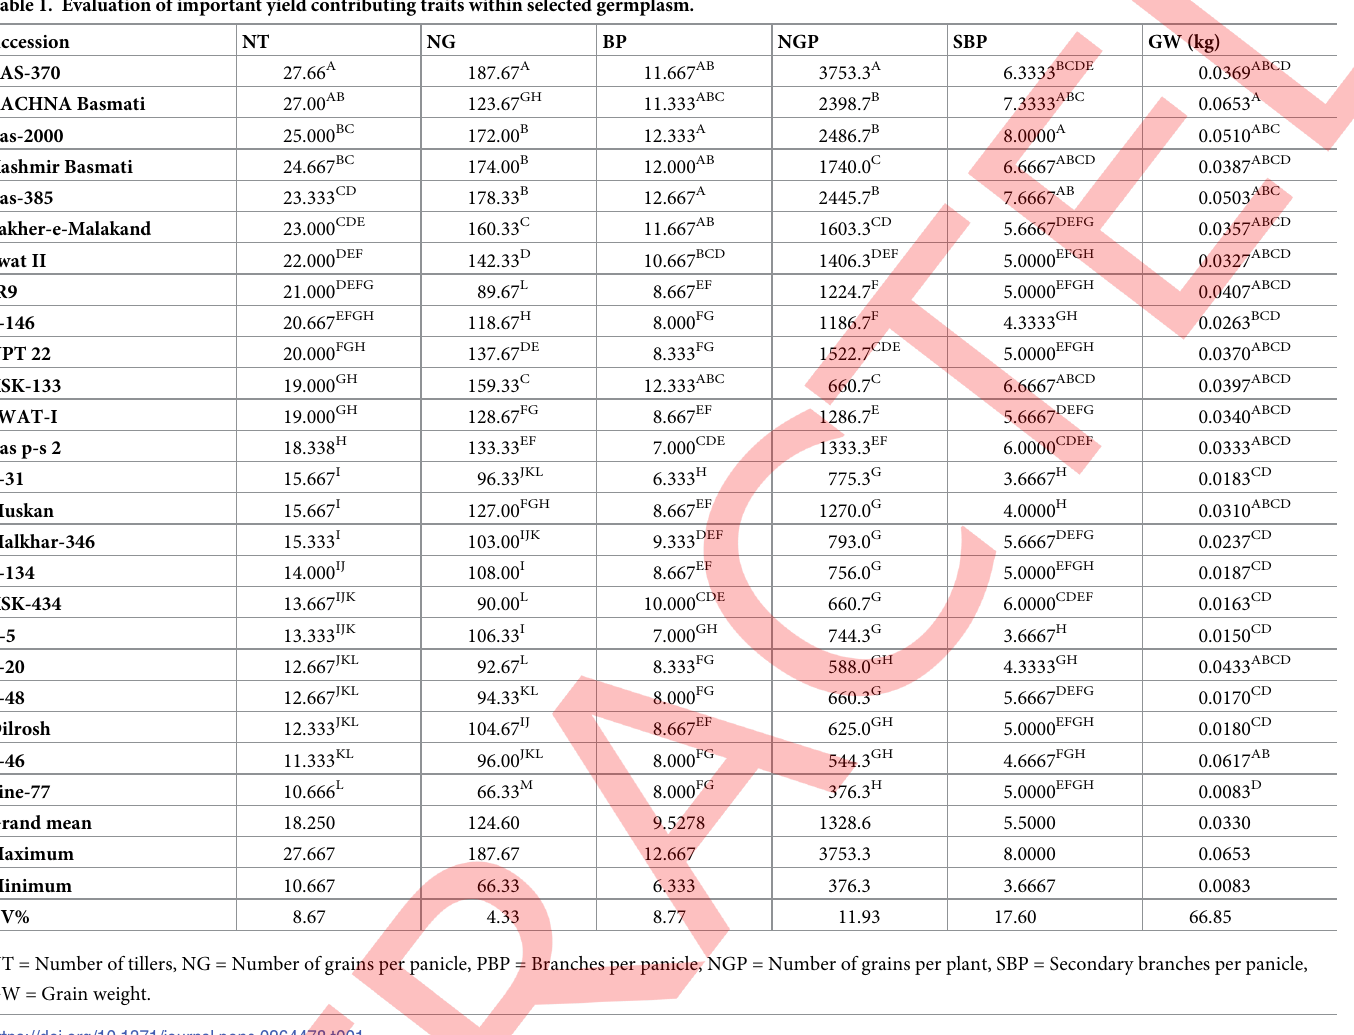
Table 1. Evaluation of important yield contributing traits within selected